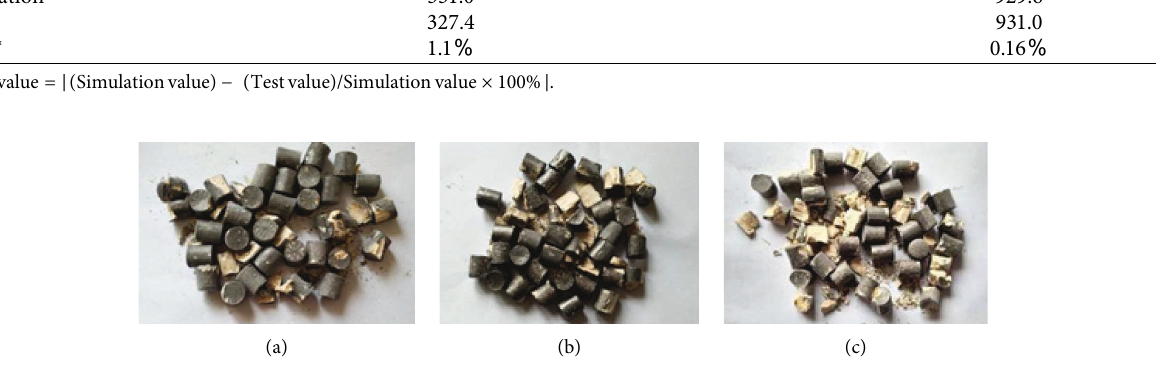
Figure 2: Broken samples of different aging times under the same pressure; (a) samples without storage; (b) samples aged for 15 days; (c) samples aged for 30 days. Table 2: Test data of propellant fragmentation without storage.